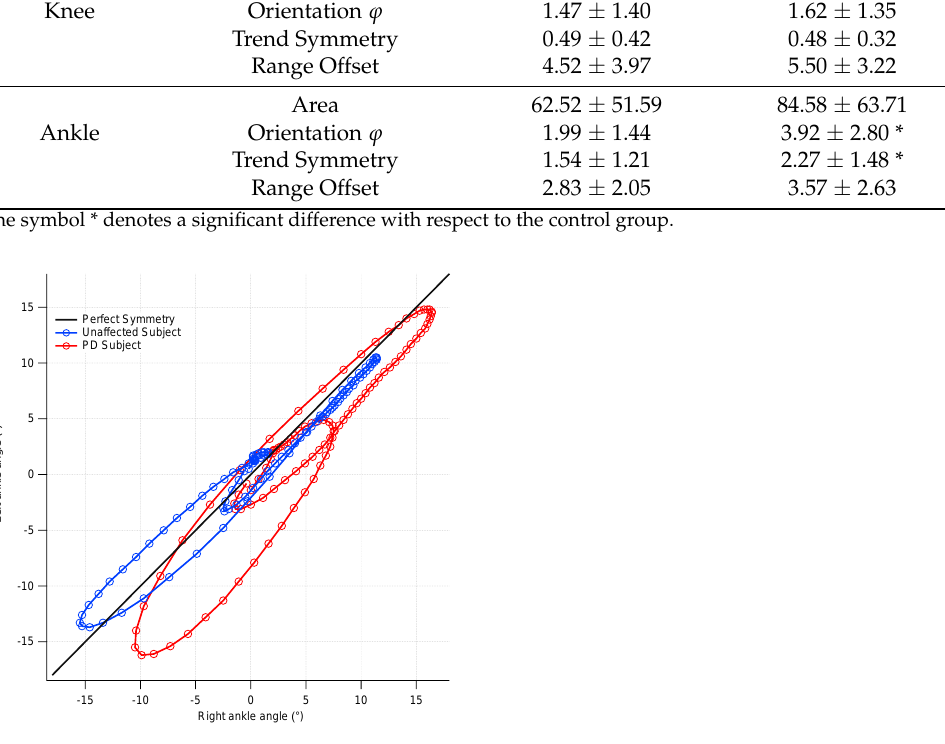
Figure 3. Comparison between cyclograms of an individual affected by PD and an unaffected individual. The diagram refers to the ankle joint. Table 6. Comparison between symmetry indexes of PD and CG subjects. Values are expressed as mean ± SD.